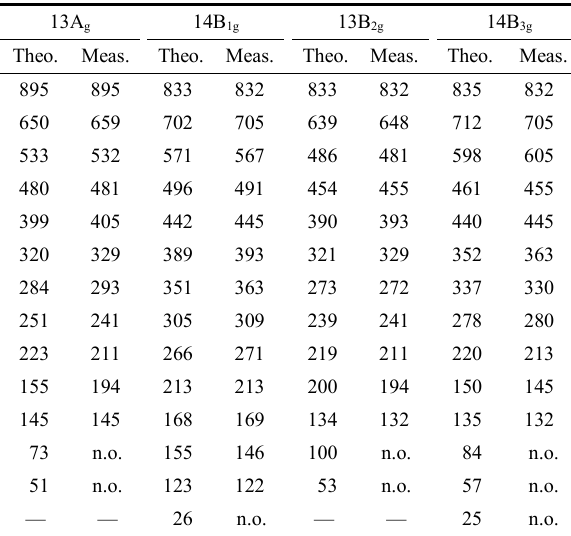
Complied polarized Raman modes for the the increase of the symmetry of the crystal because of ZnNb 2 O 6 single crystal and theoretical date. Reproduced the sample transition from the disordered phase with permission from Ref. [18], © AIP Publishing LLC structure for x = 0.3 to single columbite phase